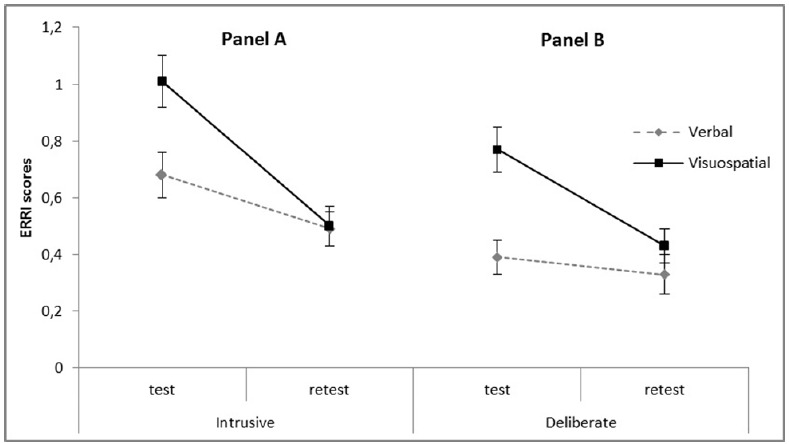
Two-way interaction effects of Task modality by Test–retest on the ERRI scores, Experiment 1. (A) The two-way interaction effects of Task modality by Test–retest on Intrusive index was significant in that, at the test, participants assigned to the Visuospatial condition reported higher scores of Intrusive rumination as compared with participants assigned to the Verbal condition. This significant divergence vanished at retest, although a significant decrease over time was observed for both conditions of task modality. (B) The two-way interaction effects of Task modality by Test–retest on Deliberate index was significant. Analyses of the simple effects demonstrated that, at the test, rates of Deliberate rumination were significantly higher in the Visuospatial condition as compared with the Verbal, but significantly dropped over time in the Visuospatial task condition, while remaining substantially stable in the Verbal condition. The significant divergence observed at test vanished at retest. Error bars represent ± 1 SE.